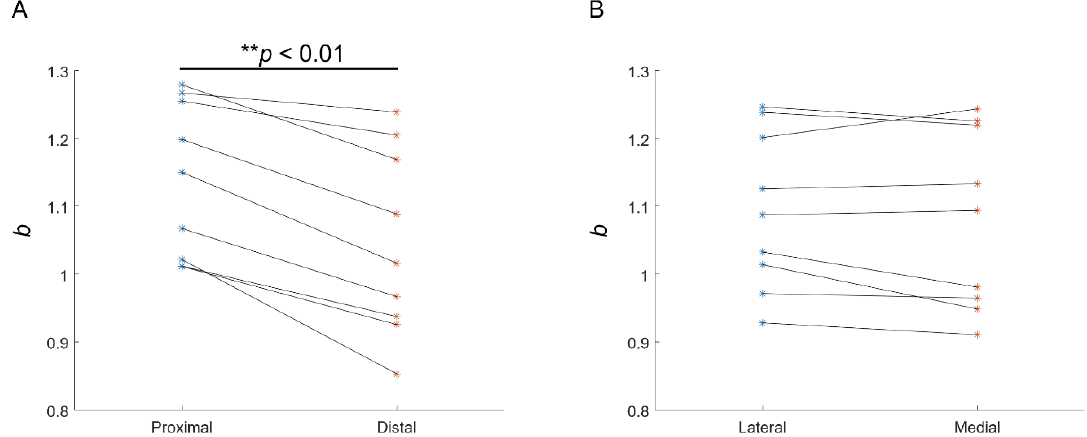
Figure 6. ( A ) Individual b for all subjects recorded from the proximal (average of all channels in rows 3 and 4) and distal (rows 10 and 11) muscle regions. ( B ) Individual b for all subjects recorded from the lateral (average of all channels in columns 1 and 2) and medial (columns 5 and 6) muscle